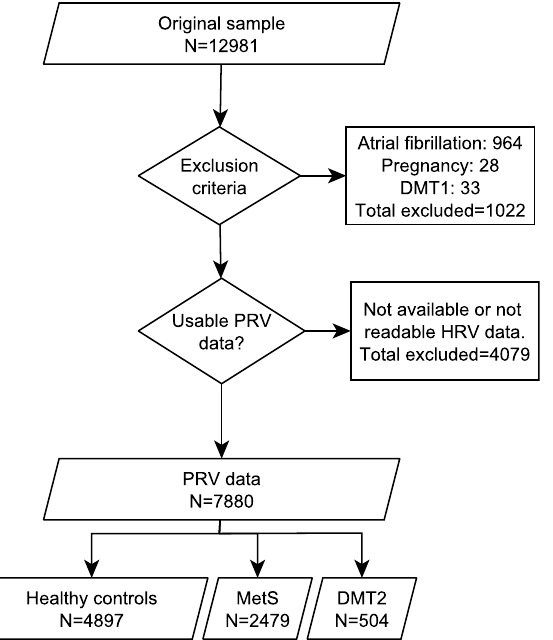
Figure 5. Flowchart describing the sample of HRV data for healthy controls, subjects with metabolic syndrome and diabetes type 2 derived from the Tromsø 6 study. DMT1 diabetes mellitus type 1, DMT2 diabetes mellitus type 2, MetS metabolic